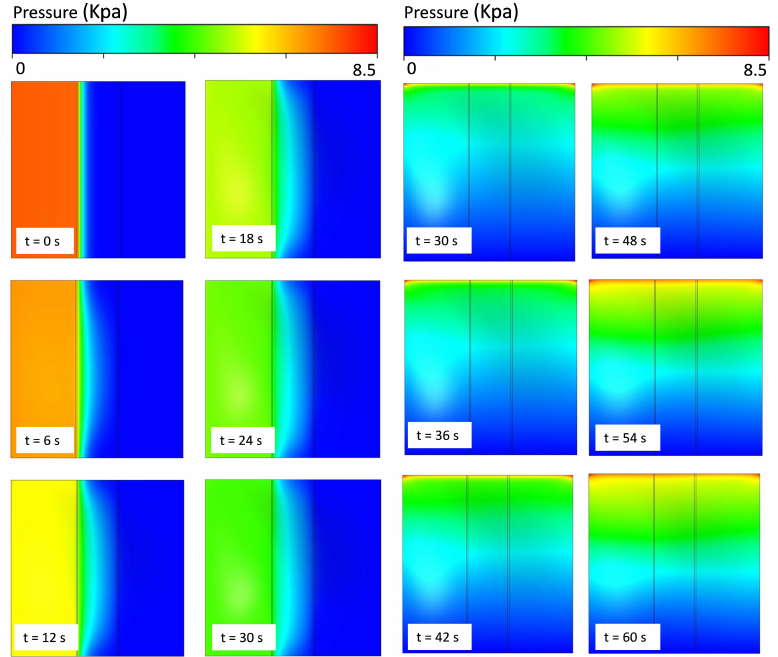
Figure 7. Pressure distribution for various time steps for L/W = 0 model in upper surfaces and lower surfaces of membranes in